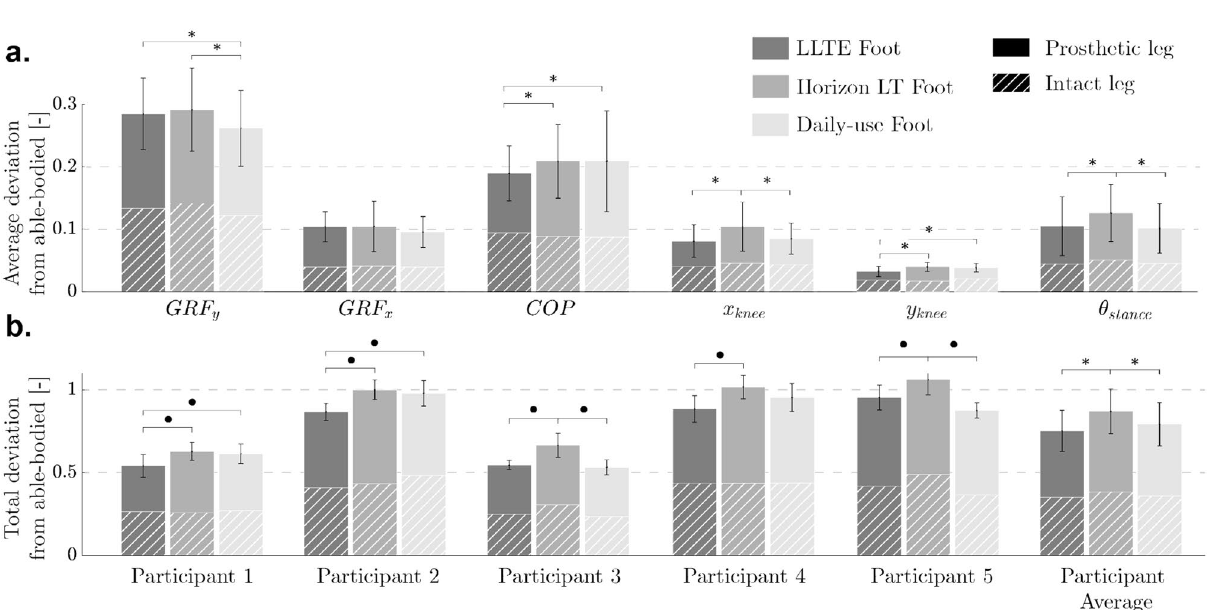
Figure 5. Deviation from able-bodied reference data, calculated using normalized root mean square errors (NRMSE) between the measured walking data and the target able-bodied reference data for each prosthetic foot condition. ( a ) Average deviation for all participants across the different kinematic and kinetic variables. ( b ) Total deviation, summed from all six kinematic and kinetic variables shown for each participant. Group level statistical significance between prosthetic feet conditions is shown with *, and individual statistical significance is shown with